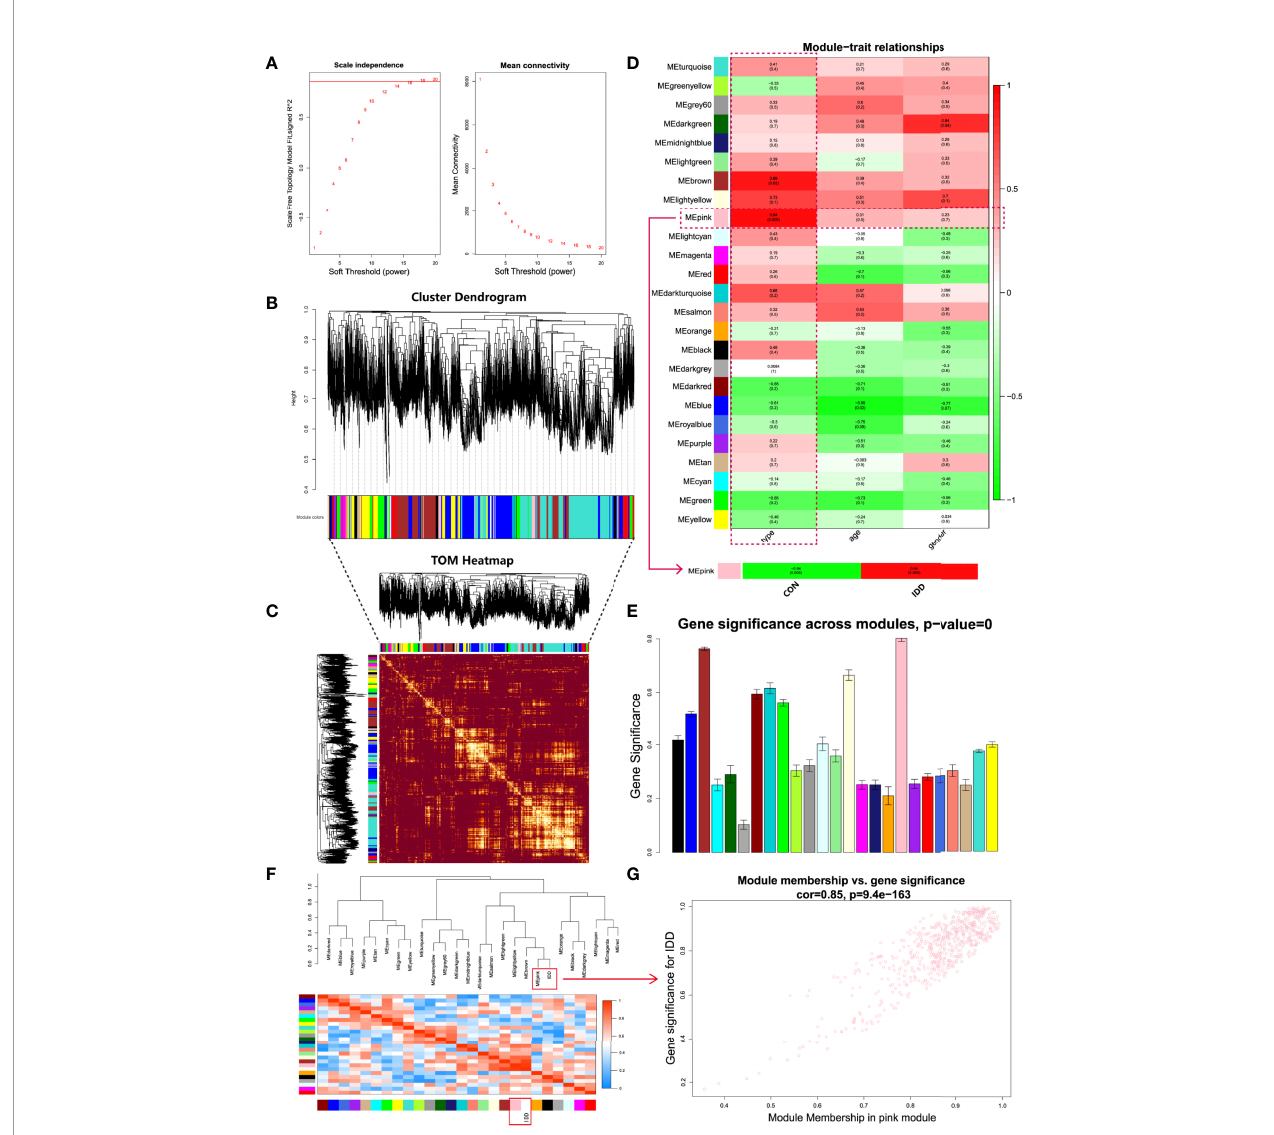
FIGURE 2 | Comprehensive weighted gene co-expression network analysis. (A) , Selection of soft threshold power value. Left panel displayed scale-free model fi t index of different power values; right panel indicated the mean connectivity of these values. (B) , Clustering dendrogram of all genes based on dissimilarity algorithm and assignment modules. (C) , Topological overlap heatmap of the weighted co-expression network. Each row and column represented genes, different colors in x and y axis represented different clustered modules. Light area indicated high topological overlap within network. (D) , Module-trait correlation heatmap between clinical traits and modules. (E) , Histogram of gene signi fi cance across modules showed pink module was the most signi fi cant module in degenerative CEP group. (F) , Cluster dendrogram and heatmap of adjacency eigenvalue in the network. (G) , Correlation scatter plot between gene signi fi cance and module membership in pink